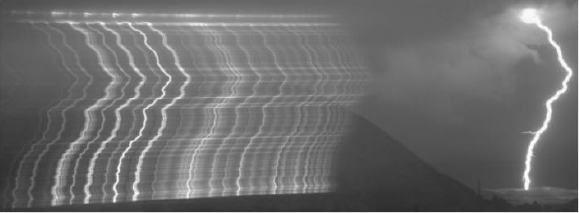
Figure1. The original spectral image obtained by a slit-free grating spectrometer